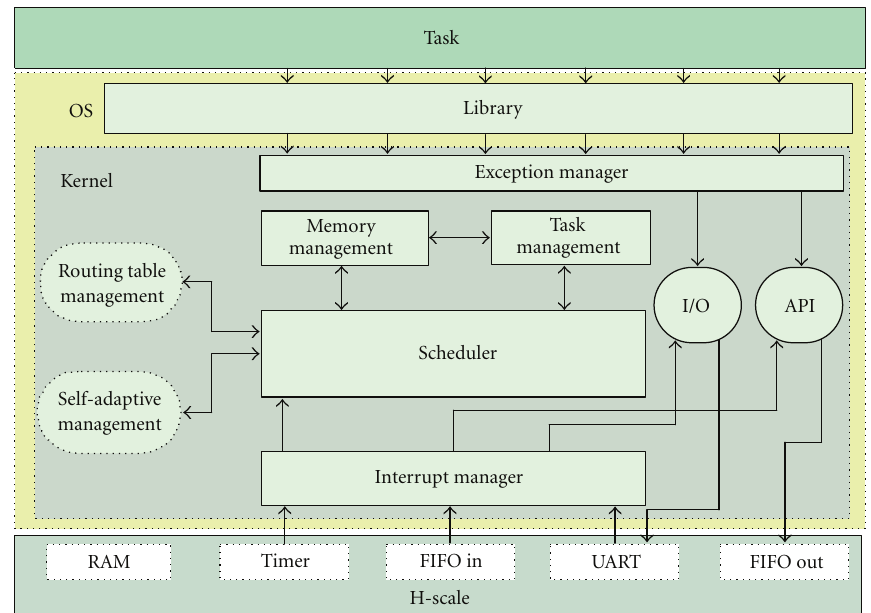
Figure 6: Operating system overview.